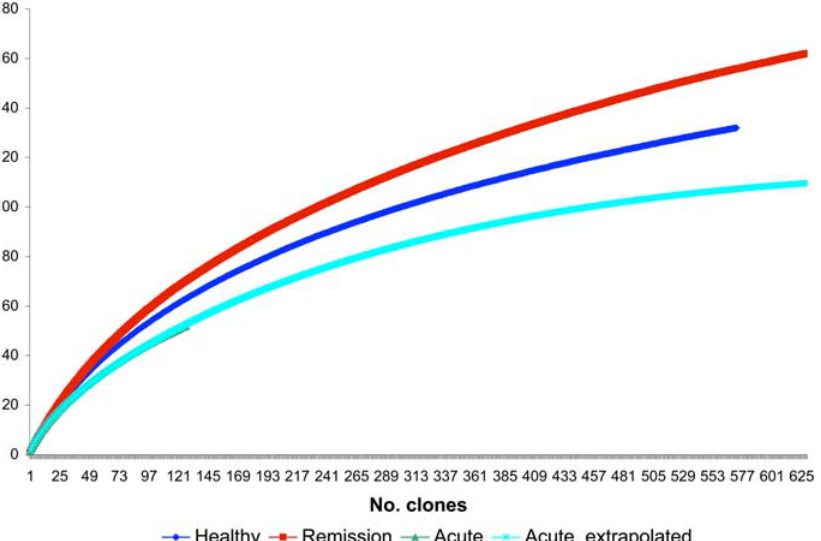
Figure 1. Rarefaction curves obtained for clone libraries from healthy controls and FMF patients. The rarefaction curves were generated by plotting the number of phylotypes (defined at 99% level) against the number of clones sequenced. The shape of the curves of observed phylotype richness indicates a trend of diminishing chance of finding new phylotypes as the sampling continues. Data for library in attack were extrapolated by empiric regression function a 6 x 2 b 6 exp( 2 c 6 x). Coefficient of regression determination (R 2 ) was 99.9%. Regression statistics: adjusted R 2 – 0.9991; standard error – 0.1720; a=1.8690; b=0.7104; c=8.0466E-04. Healthy controls are shown in dark blue; FMF patients in remission – in red and attack – in green, the extrapolated curve is shown in light